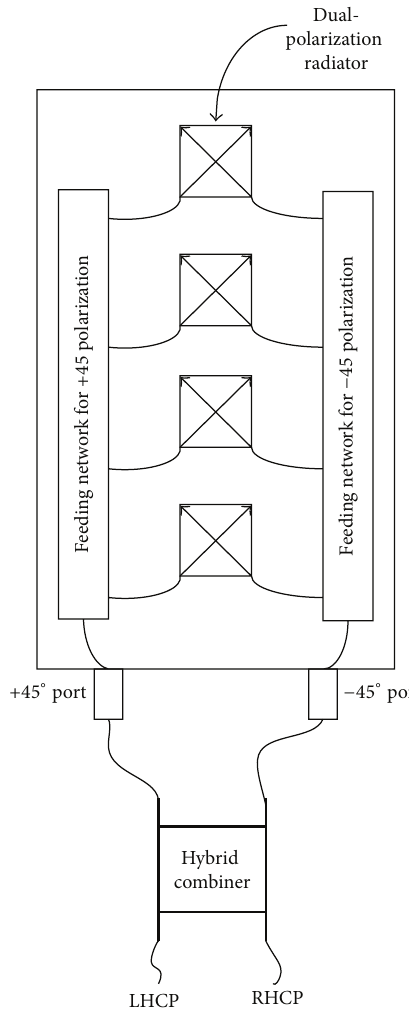
Figure 6: The realization of CPA by ± 45 ∘ dual-polarized